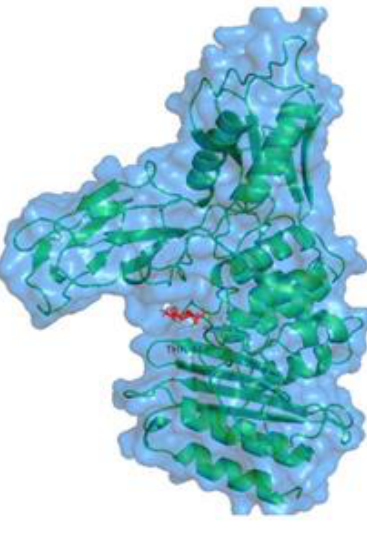
Figure 8. The molecular interaction of the compound 2-acetamido-2-deoxy-hexopyranose with penicillin-binding protein.